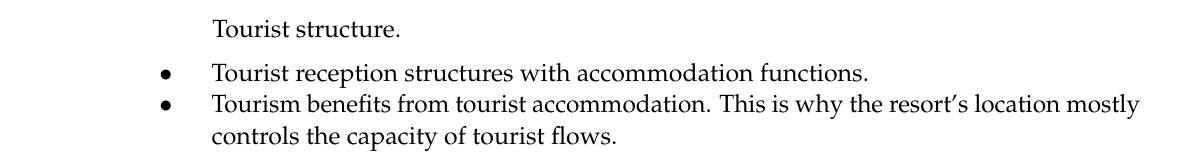
Total domains of activity, of